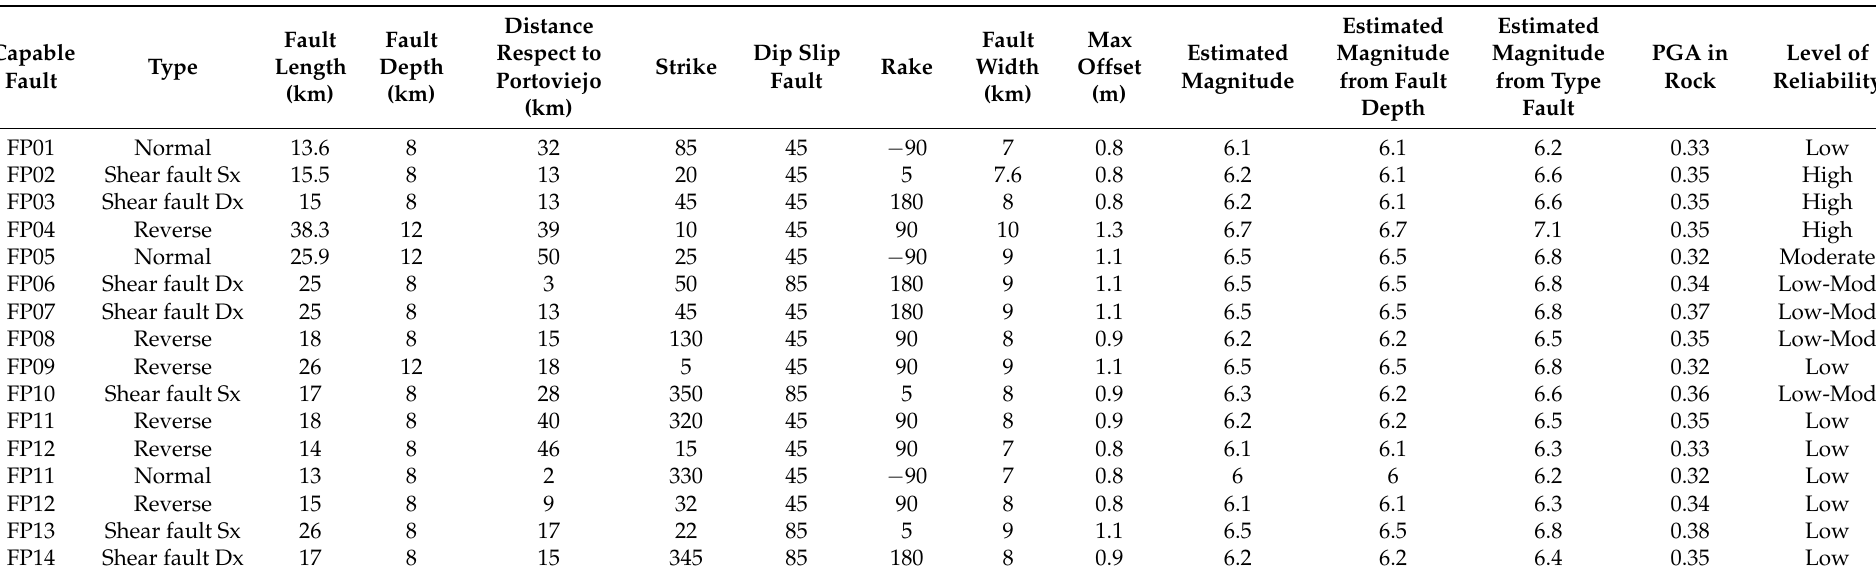
Table 2. List of faults that are able to generate seismic movement with a magnitude greater than Mw 6 in the canton of Portoviejo. Estimated Magnitude from type fault was taken from Wesnousky (2008), the estimated Magnitude was taken from [73], and the level of reliability was from